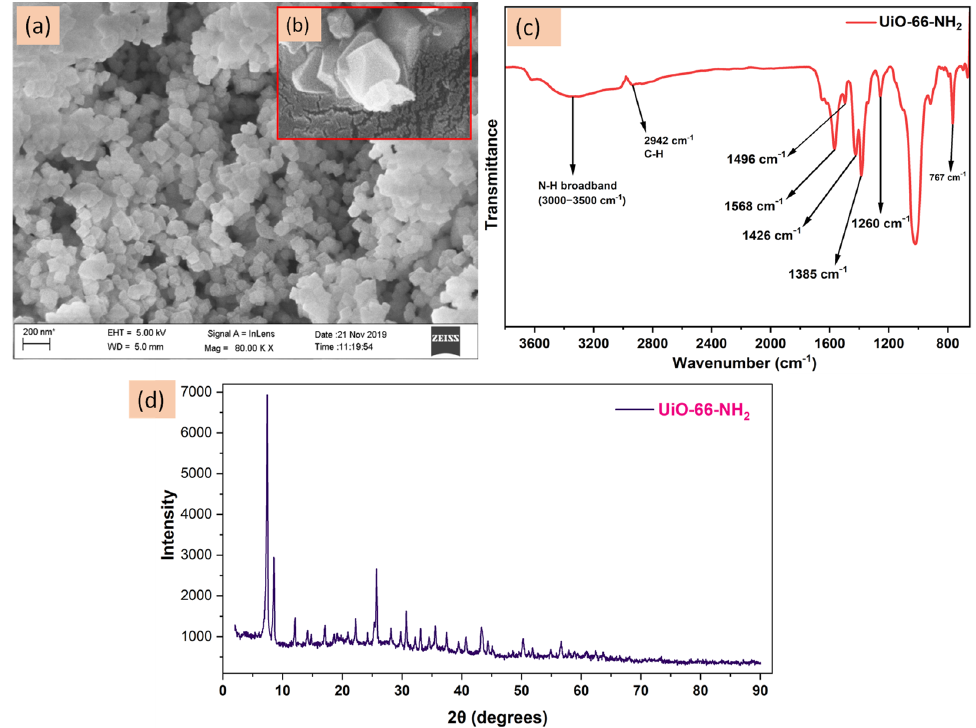
Figure 3. The obtained ( a ) FE-SEM image at 200 nm scale, ( b ) FE-SEM image showing the shape of UiO-66-NH 2 , ( c ) ATR-FTIR spectrum for UiO-66-NH 2 nanoparticles and ( d ) P-XRD pattern obtained for UiO-66-NH 2 .